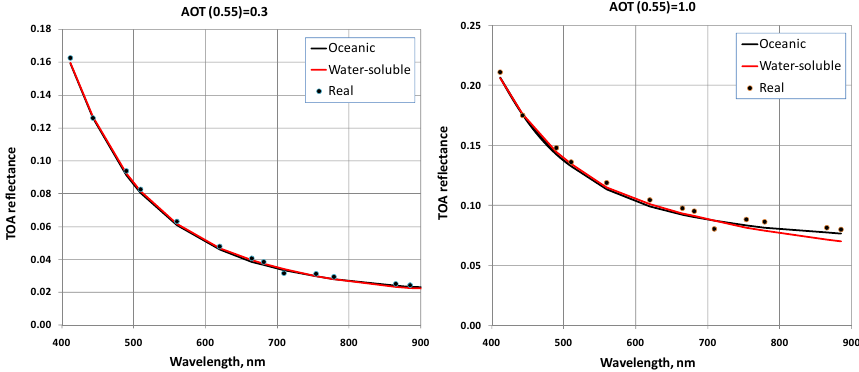
Fig. 22. Spectral reflectance at the TOA computed using code RAY with the retrieved AOT values and atmosphere models used for the retrieval for the AOT equal to 0.3 (left) and 1.0 (right) at λ = 550nm.